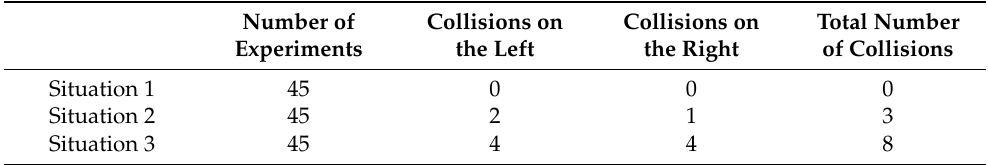
Table 7. Number of collisions in each situation.